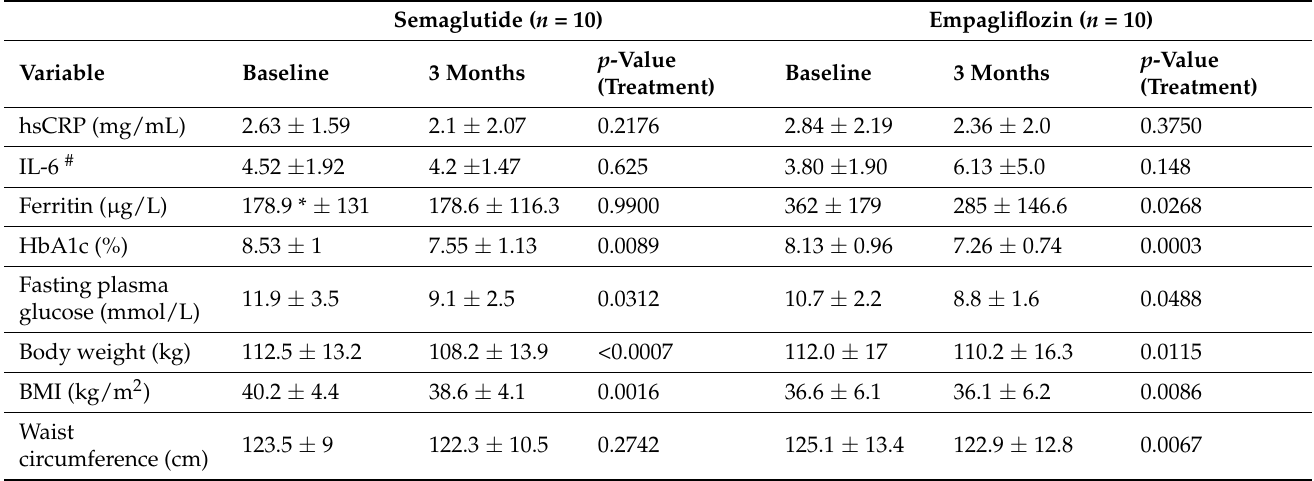
Table 1. Clinical and biochemical parameters at baseline and after